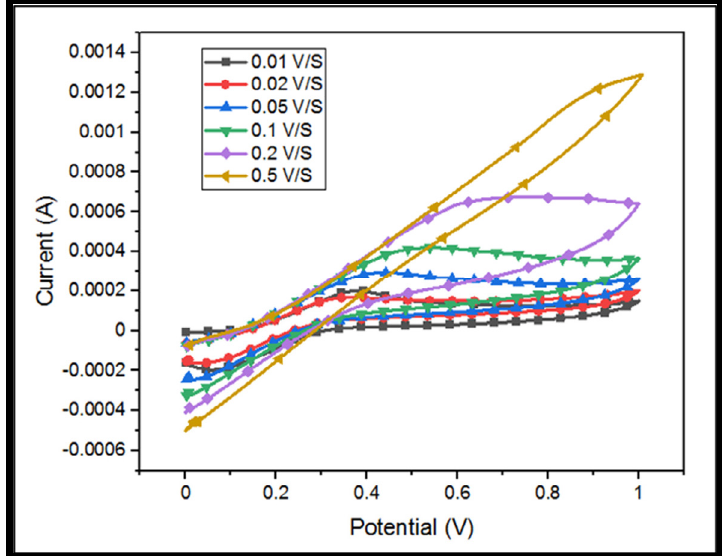
Fig. 6. Cyclic Voltammetry curve of the OP-LSG electrode collected at scan rates from 0.01 to 0.5 V/s.